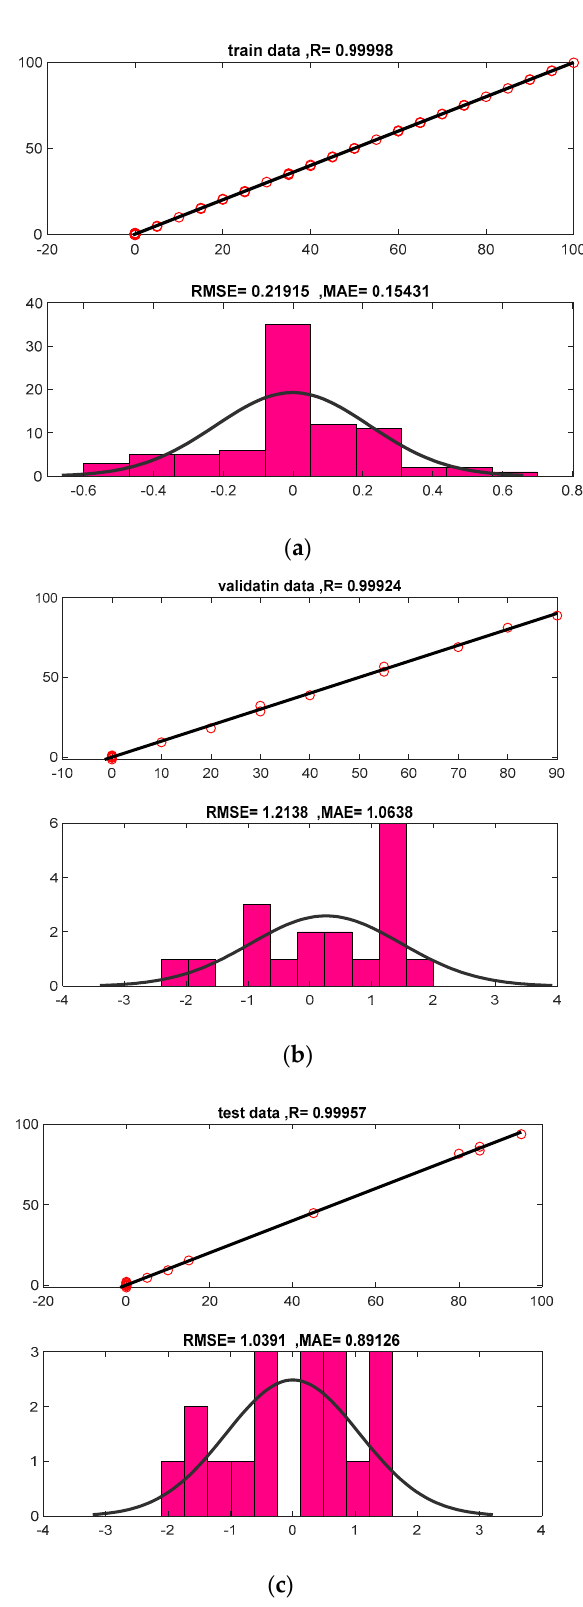
Figure 7. Operation of the designed neural network to detect the volumetric ratio of crude oil ( a ) train data, ( b ) validation data, and ( c ) test data.